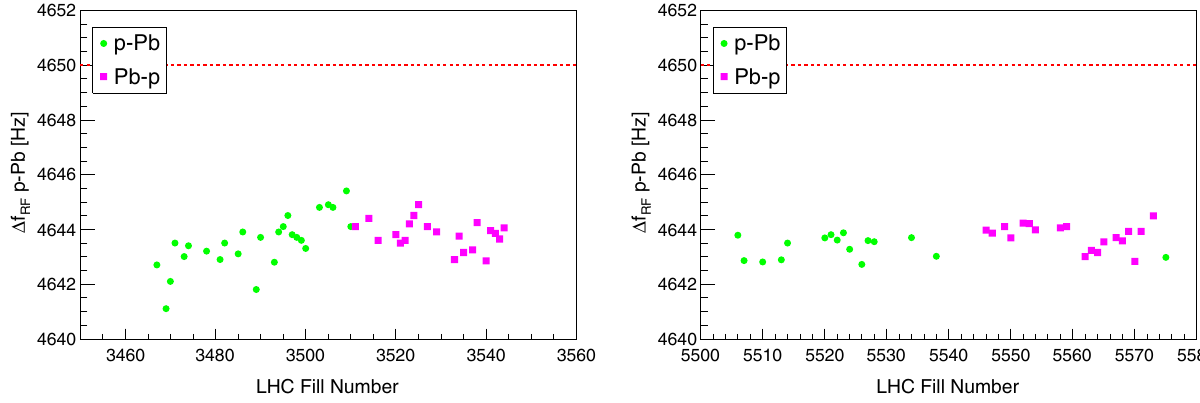
FIG. 14. Time dependence of the frequency difference Δ f of protons and lead ions as a function of the LHC fill number in 2013 (left) rf and 2016 (right). The red dotted line is the frequency difference corresponding to an energy of 450 . 0 GeV = c.